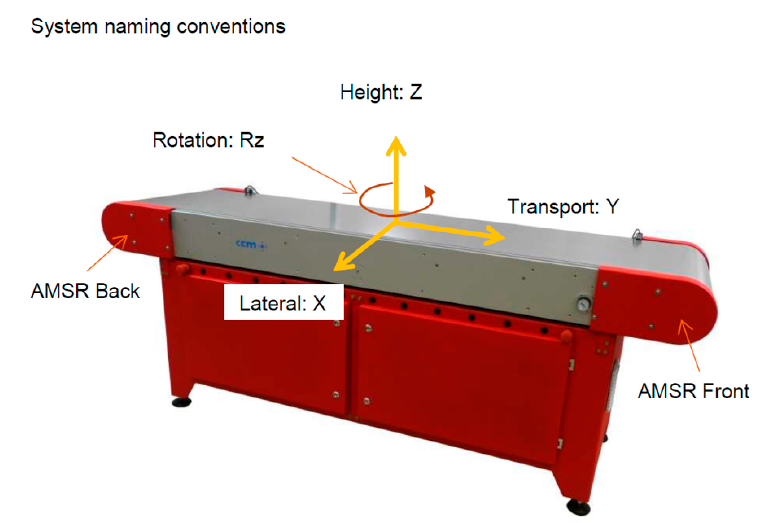
Figure 8. Pilot 1—Generic Substrate Carrier (GSC) motion axis configuration.